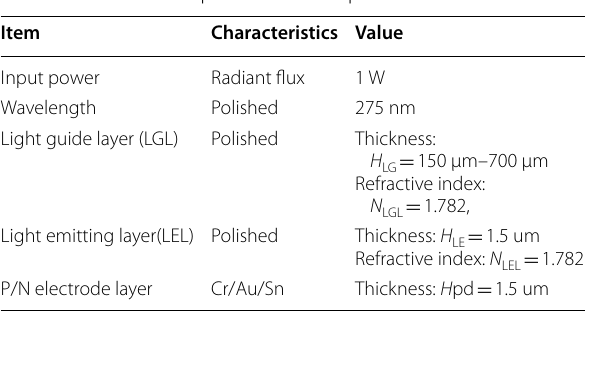
Table 1 UV‑C LED chip simulation set parameters